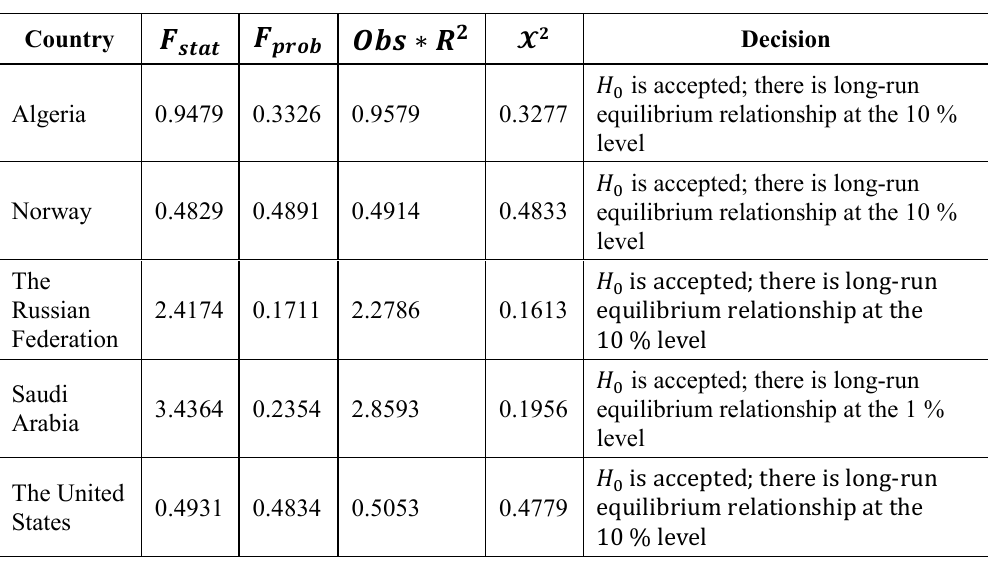
Table 3 . Heteroskedasticity, ARCH